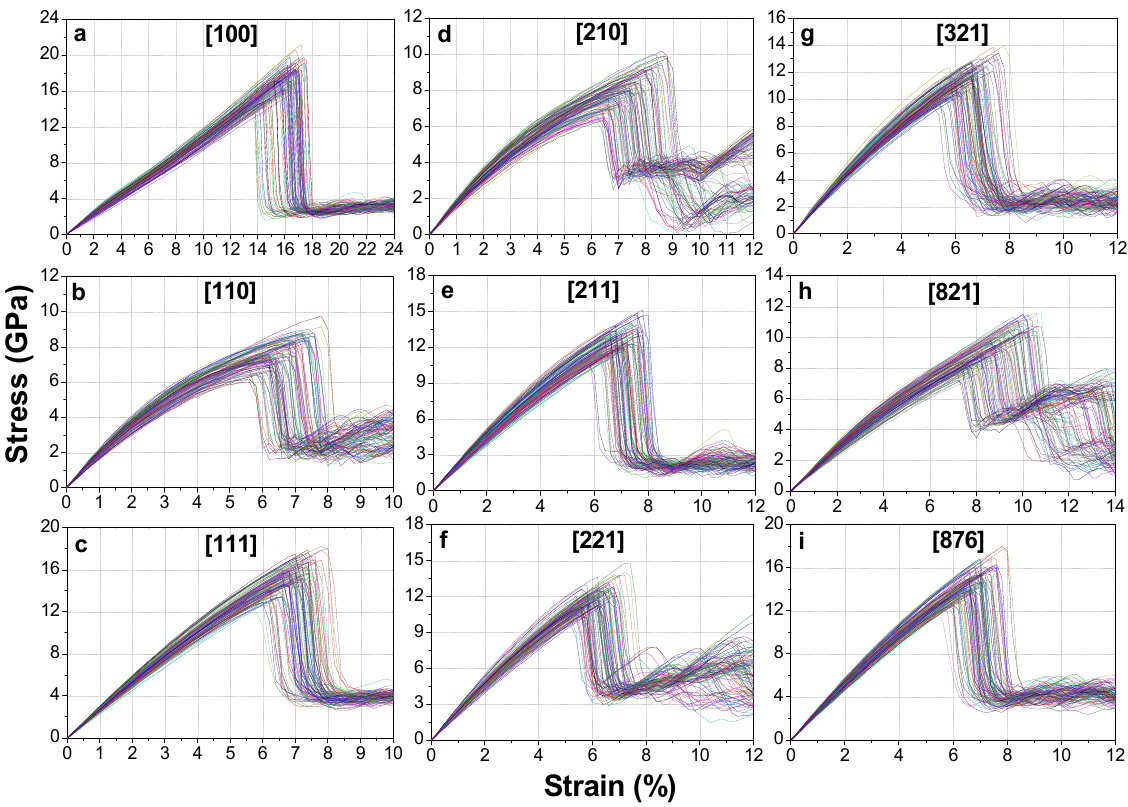
Figure 4. Stress-strain response of the single crystal HEA samples with various element compositions. ( a – i ) Results of different crystallographic orientations, including [100], [110], [111], [210], [211], [221], [321], [821], and [876]. Each branch figure contains the result of one equiatomic sample and 100 non-equiatomic samples.